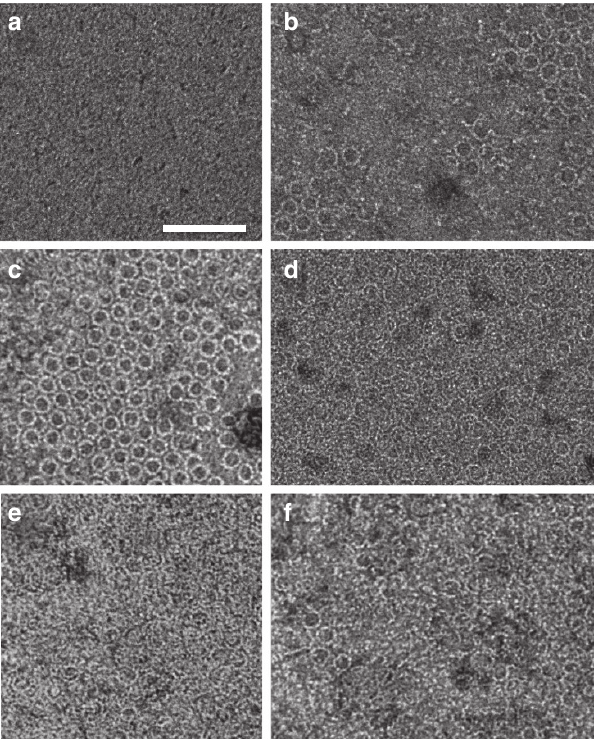
Figure 3 | FtsA minirings on lipid monolayers visualized by negative stain transmission electron microscopy. ( a ) Monolayer with buffer þ ATP but no FtsA; ( b ) 0.1 m M FtsA þ ATP, showing miniring arrays; ( c ) 0.5 m M FtsA þ ATP, showing a larger FtsA miniring array; ( d ) 1 m M FtsA þ ATP; ( e , f ) 0.5 m M FtsA with no added ATP ( e ) or with ATP ( f ) from the same experiment. Scale bar,